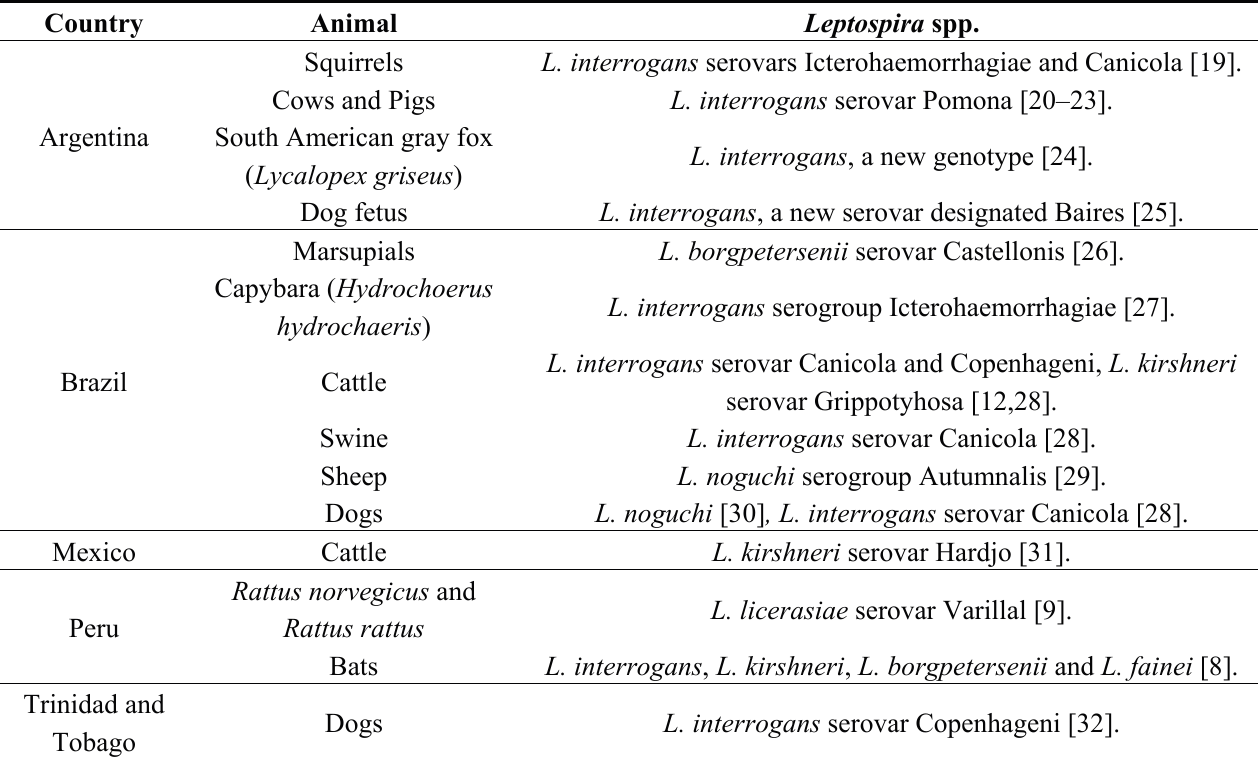
Table 1. Leptospira species, serovars and genotypes isolated from infected animals in LAC,